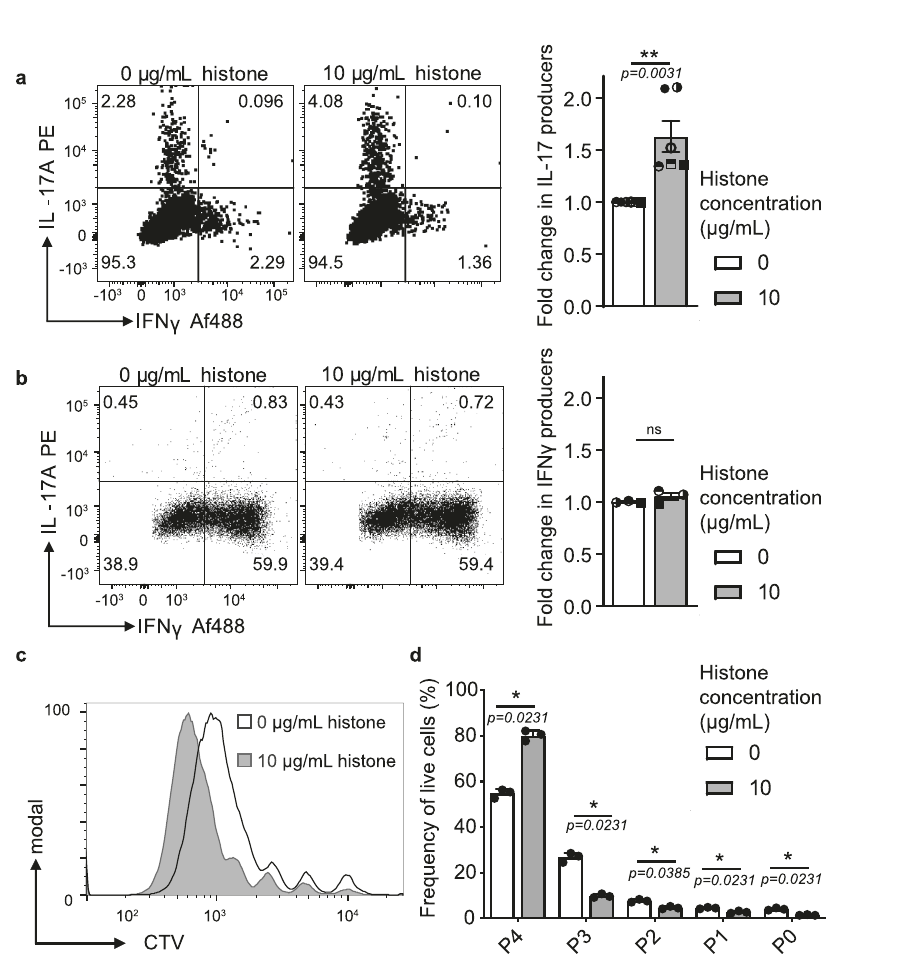
Fig. 4 Histone-induced promotion of Th17 cell differentiation is conserved in humans. Differentiation of human a Th17 cells and b Th1 cells under differentiating conditions in the presence or absence of histones for 6 days was measured by IL-17 and IFN γ production by fl ow cytometry. Key cytokine production of each subset was normalized to the 0 µ g/mL histone condition for each donor n (a) = 6, n (b) = 3. c Proliferation of Th17 cell cultures in the presence or absence of histones was measured by dilution of CTV using fl ow cytometry and d peaks indicating cell divisions quanti fi ed n = 3. Data bars show mean ± SEM. “ ns ” (not signi fi cant), p > 0.05; “ * ” p < 0.05; “ ** ” p < 0.01. a , b Paired two-tailed t -test d two-tailed t -test with Holm – Sidak